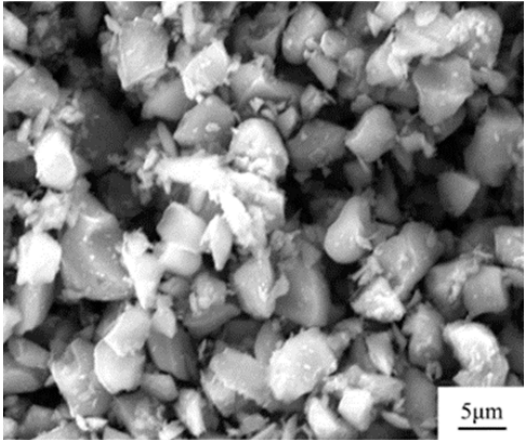
Figure 2. Raw material characterization of B 4 C powder.